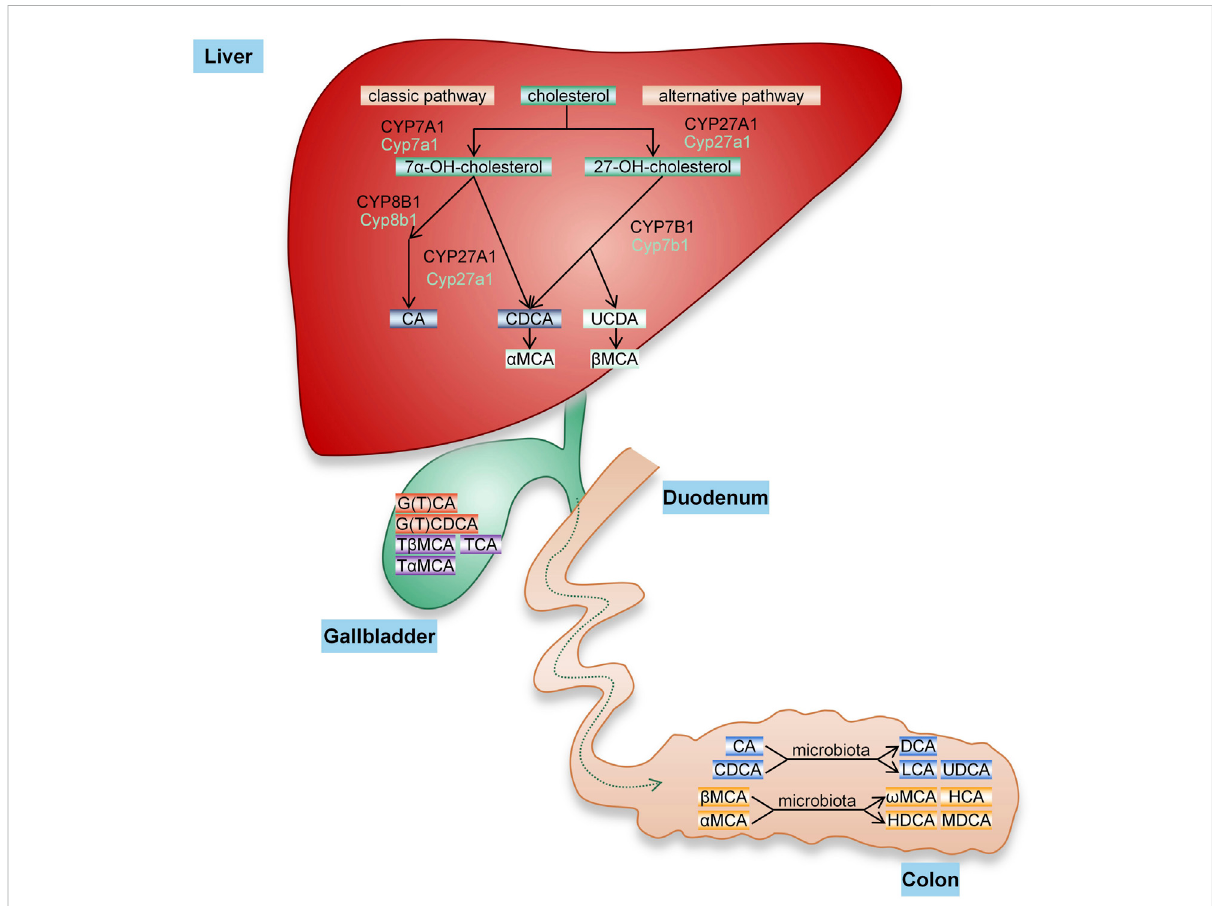
FIGURE 1 BA synthesis. The conversion of cholesterol into BA in the liver occurs through two pathways. The classical pathway of BA synthesis is initiated by CYP7A1, while the alternative pathway is initiated by CYP27A1. CA and CDCA are two main primary BAs synthesized in the human liver that are secreted into bile, bound to glycine or taurine and fi nally excreted into the intestine. In the gut, these primary BAs are subjected to bacterial bile salt hydrolases and dehydroxylases to produce secondary BAs, including DCA, LCA, and UDCA (rarely). In mice, CA is produced by the classical pathway,andCDCAandUDCAgeneratedbythealternativepathwayareconvertedto α -MCAand β -MCAandthenform ω -muricholicacid( ω -MCA), hyocholic acid (HCA), dehydrocholic acid (DHCA) and murideoxycholic acid (MDCA) through the action of the intestinal fl